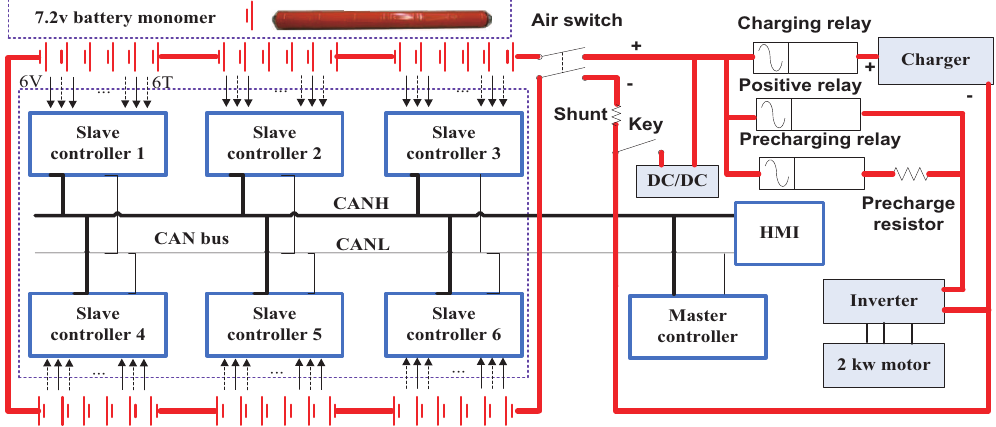
Figure 2. The electrical system diagram of electric boat. Charge relay, positive relay and precharging relay are controlled by master controller to realize charging and discharging. The serial 7.2 V monomers are monitored by each slave controller through collecting 6 road temperature (6 T) and voltage (6